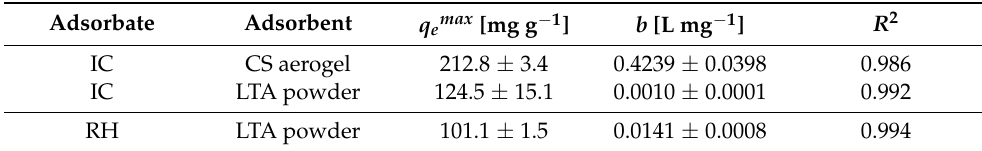
Table 1. Langmuir model best fitting parameters for adsorption isotherms for CS aerogels and LTA powder.